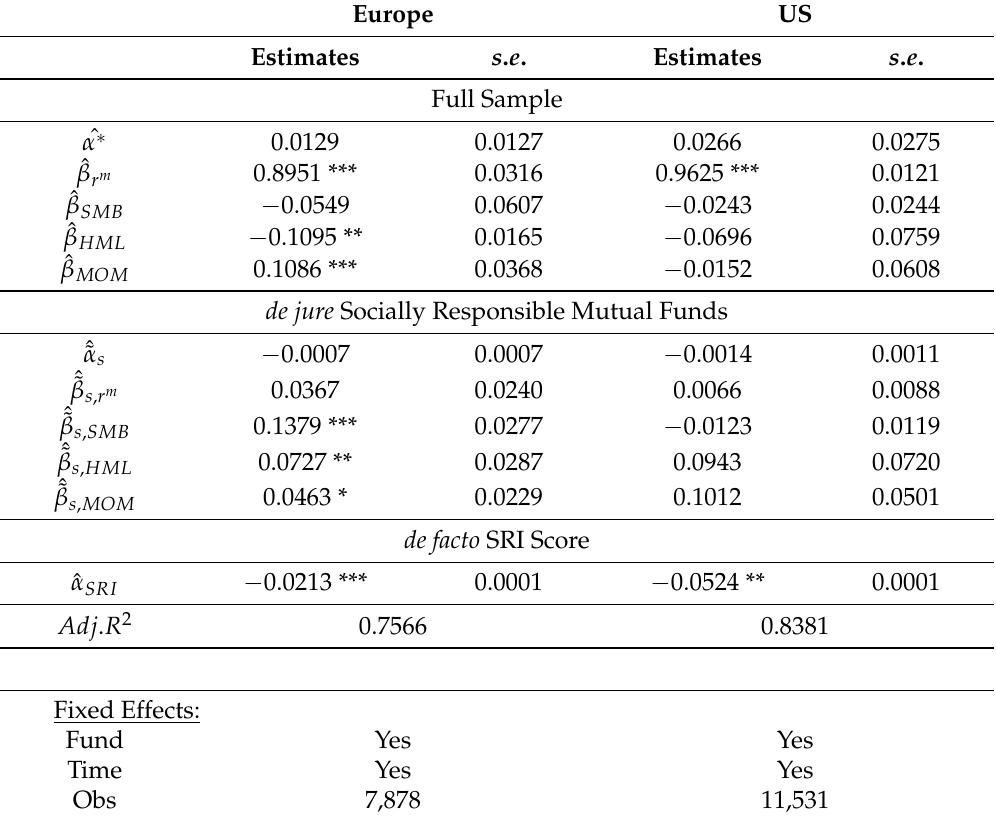
Table 8. Static (constant SRI ratings) estimation of the augmented nonlinear panel version of Carhart’s model